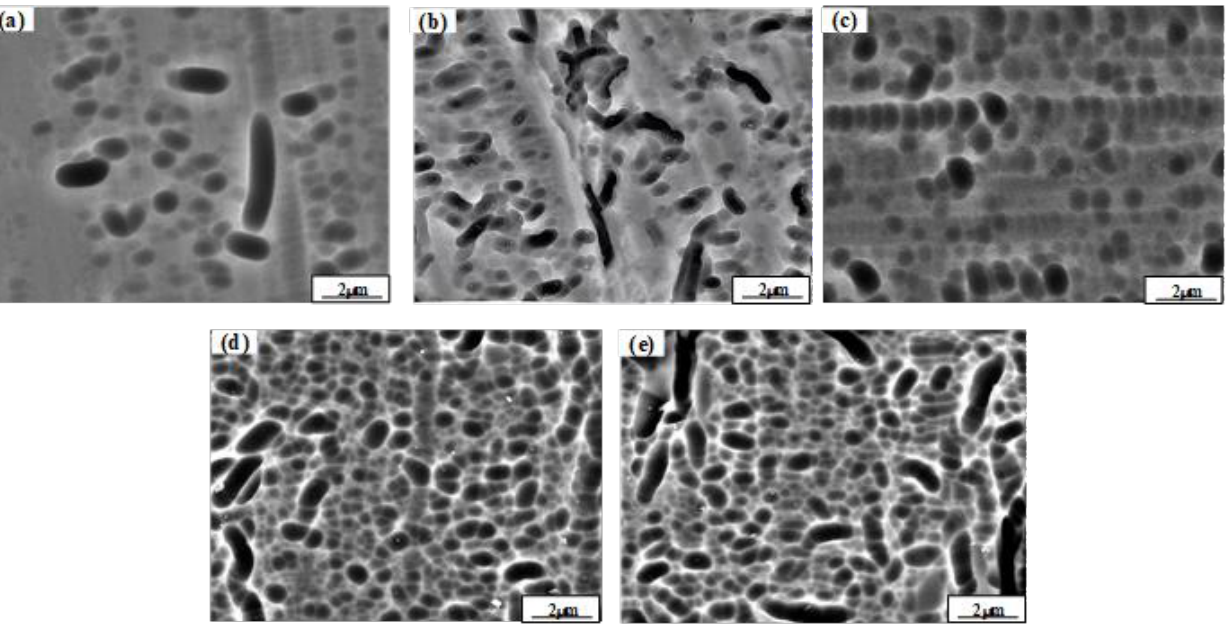
Figure 6. SEM patterns of glass-ceramics with different Fe 2 O 3 contents: ( a ) 0 wt% Fe 2 O 3 ; ( b ) 3.11 wt% Fe 2 O 3 ; ( c ) 6.21 wt% Fe 2 O 3 ; ( d ) 9.32 wt% Fe 2 O 3 ; ( e ) 12.42 wt% Fe 2 O 3 .